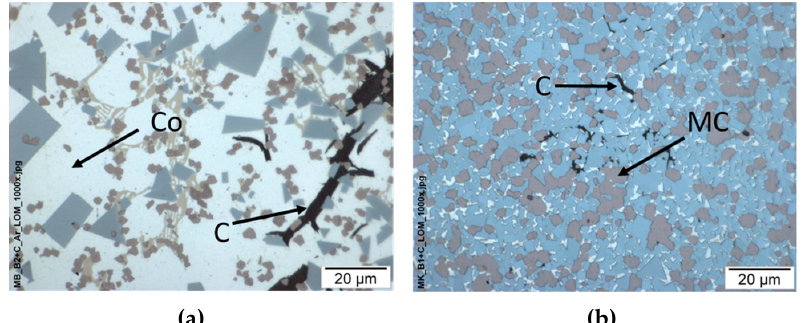
Figure 1. ( a ) Co-rich model alloy with free C (“C”) and large binder phase areas (“Co”), ( b ) model alloy with large MC/M(C,N) grains (“MC”) and free C (“C”) for electron-probe microanalysis (EPMA) point measurements.